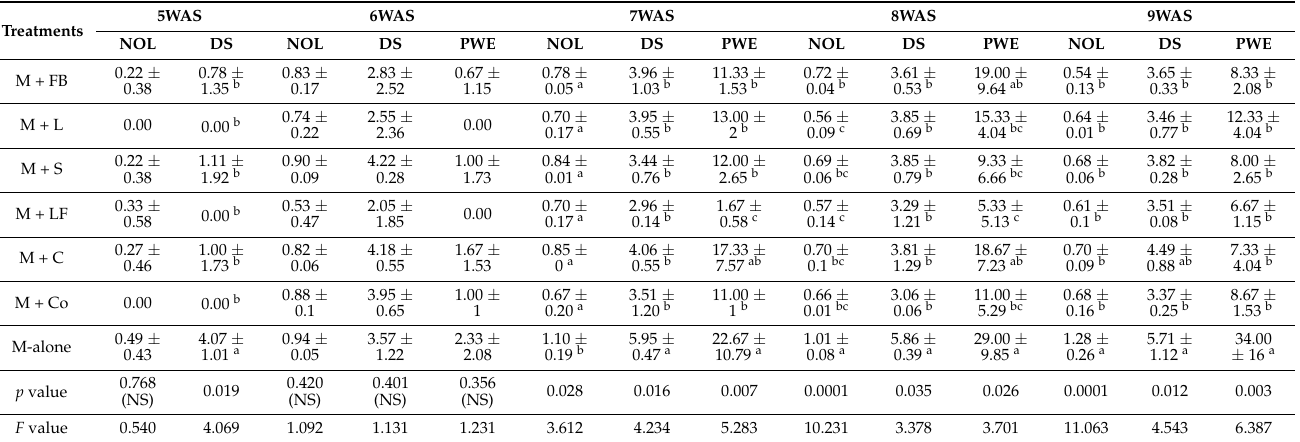
Table 5. Mean number of larvae, damage scale and mean number of plants with excreta in inter- cropped and sole crop of maize.